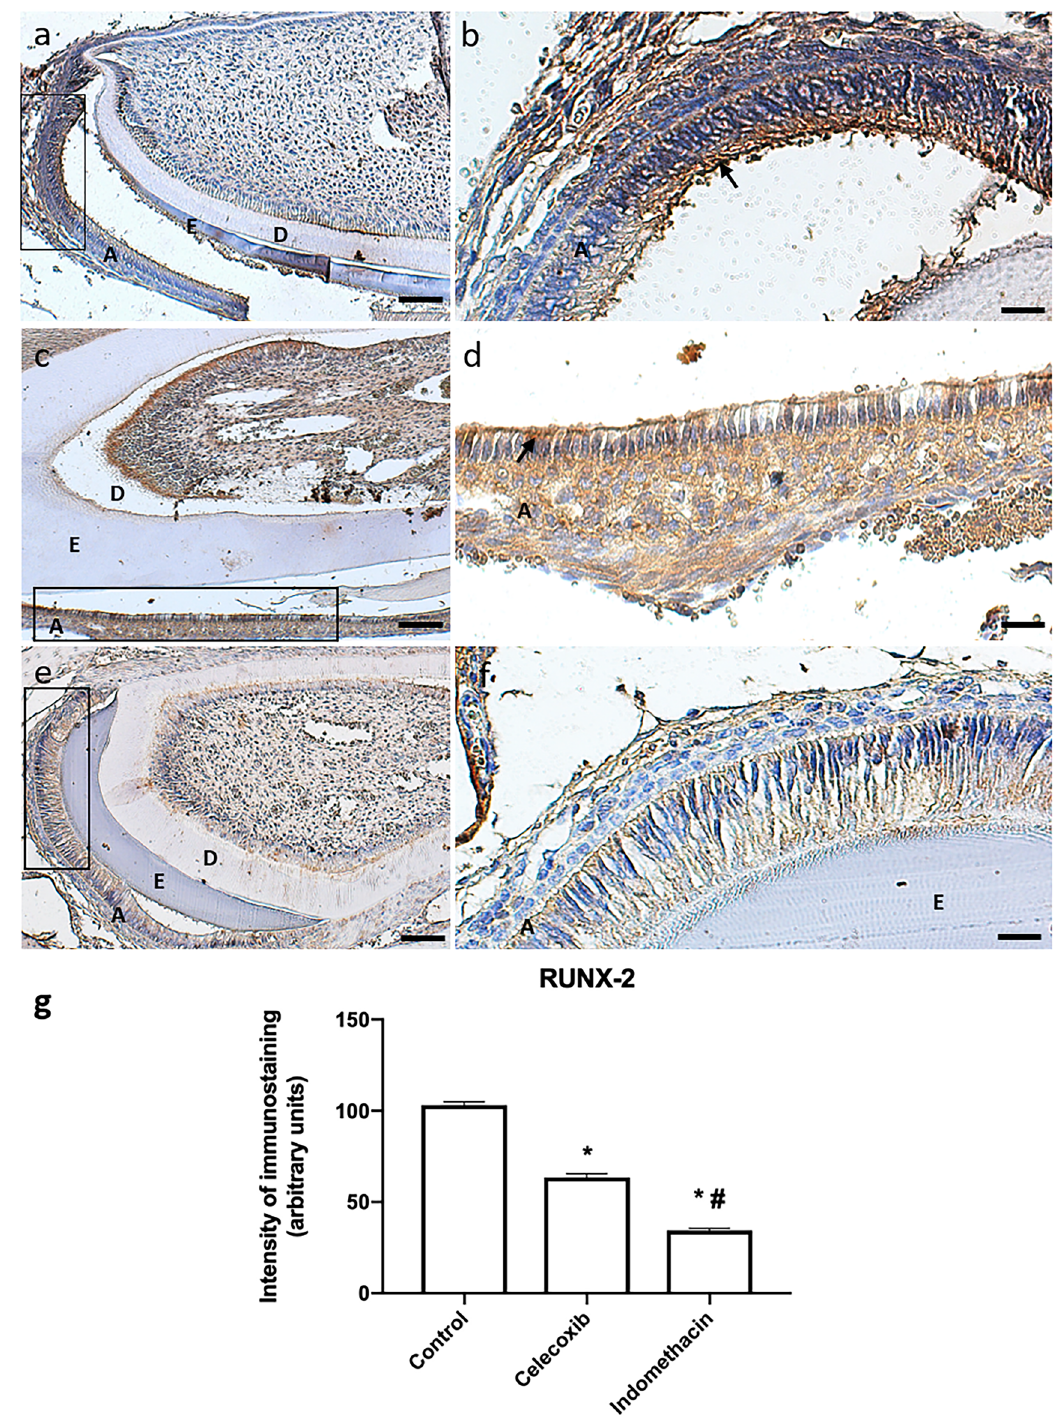
Figure 6. High expression of Runx2 in the control group (n = 20) (10 × / scale = 100 µm) ( a ), (20× / scale = 50 µm) ( b ). Animals treated with Celecoxib (n = 20) presented a slight inhibition of Runx2 in the ameloblast layer (10× / scale = 100 µm) ( c ), (20× / scale = 50 µm) ( d ). In indomethacin-treated group (n = 10), Runx2 inhibition was even more evident (10× / scale = 100 µm) ( e ), (20× / scale = 50 µm) ( f ). Graphical representation of immunostaining quantification of Runx2 protein synthesis using image deconvolution- median and interquartile range ( g ). A: ameloblasts, E: enamel layer, D: dentin